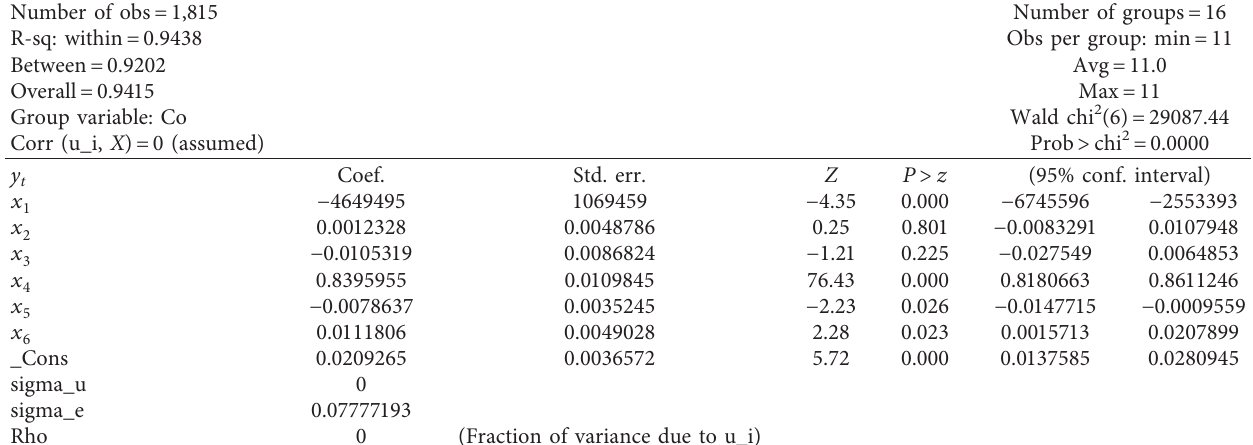
Table 3: Result of unit root.